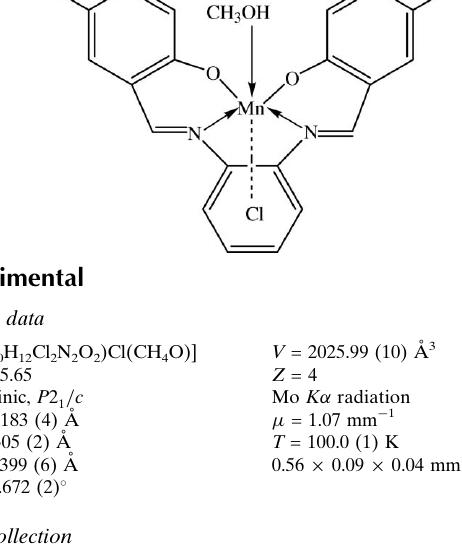
Data collection Bruker SMARTAPEX2 CCD area- detector diffractometer